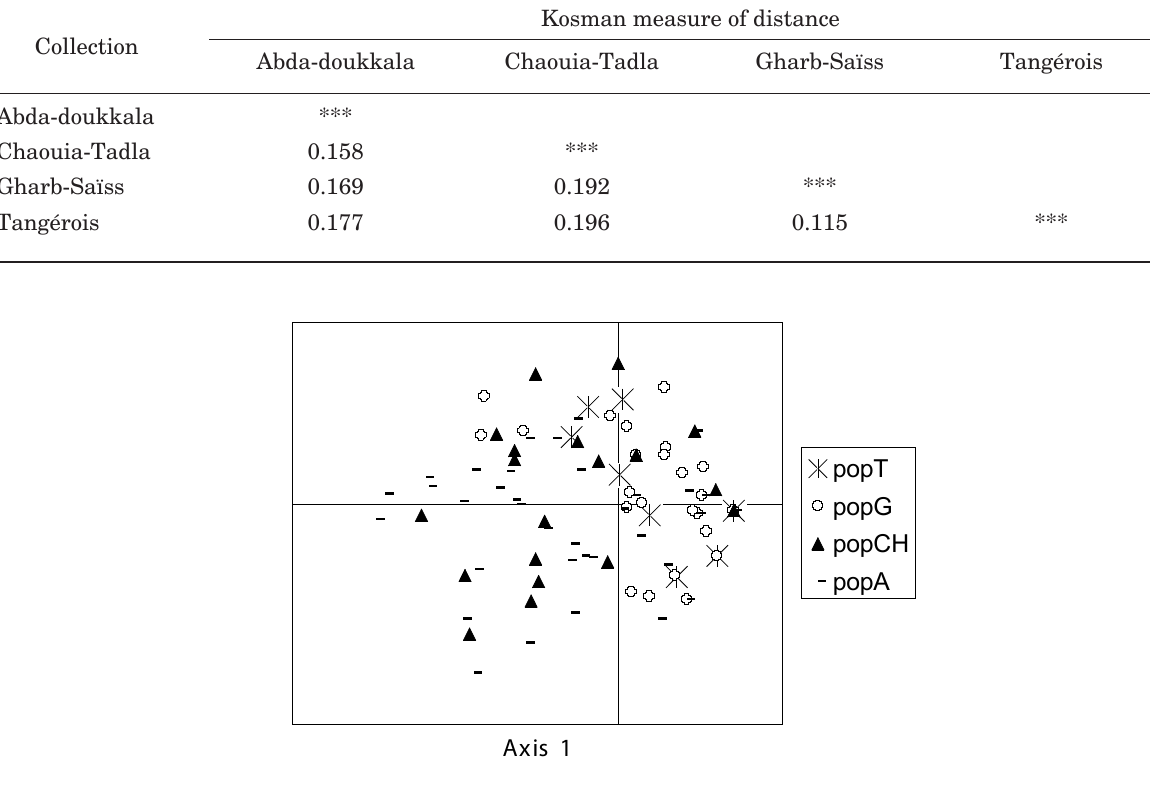
Figure 1. Principal coordinates analysis based on virulence data of 105 isolates of Puccinia recondita. Pop T: collection of Tangérois, Pop G: collection of Gharb-Saïss, Pop Ch: collection of Chaouia-Tadla, Pop A: collection of Abda-Doukkala.